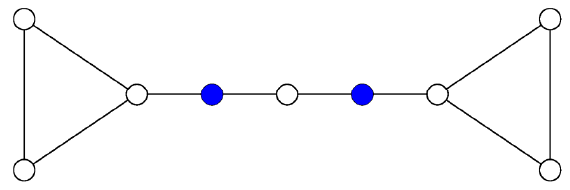
Figure 1. An example of a graph with a